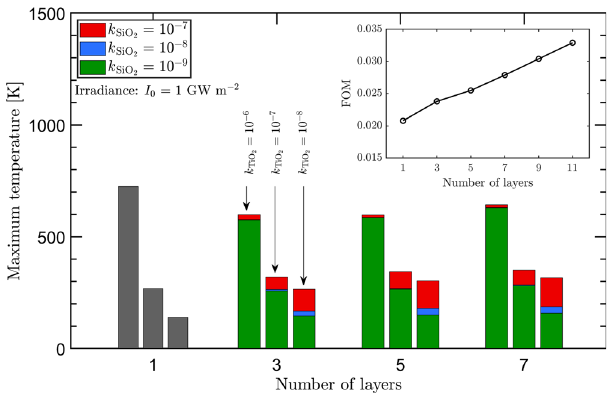
Fig. 6 Maximum temperature reached during the acceleration phase. The temperature is provided for the TiO 2 -based lightsails with SiO 2 as low- index material, for different values of extinction coef fi cients. In the inset the FOM is reported for increasing number of layers.